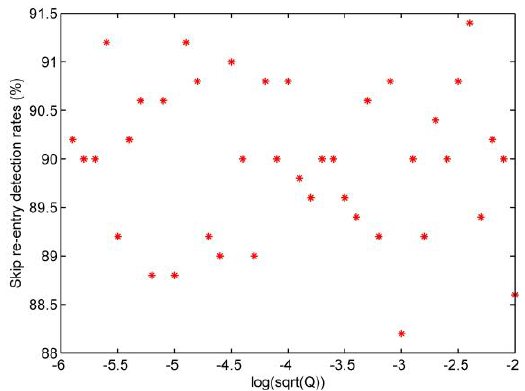
Figure 9. Skip re-entry detection rates test.